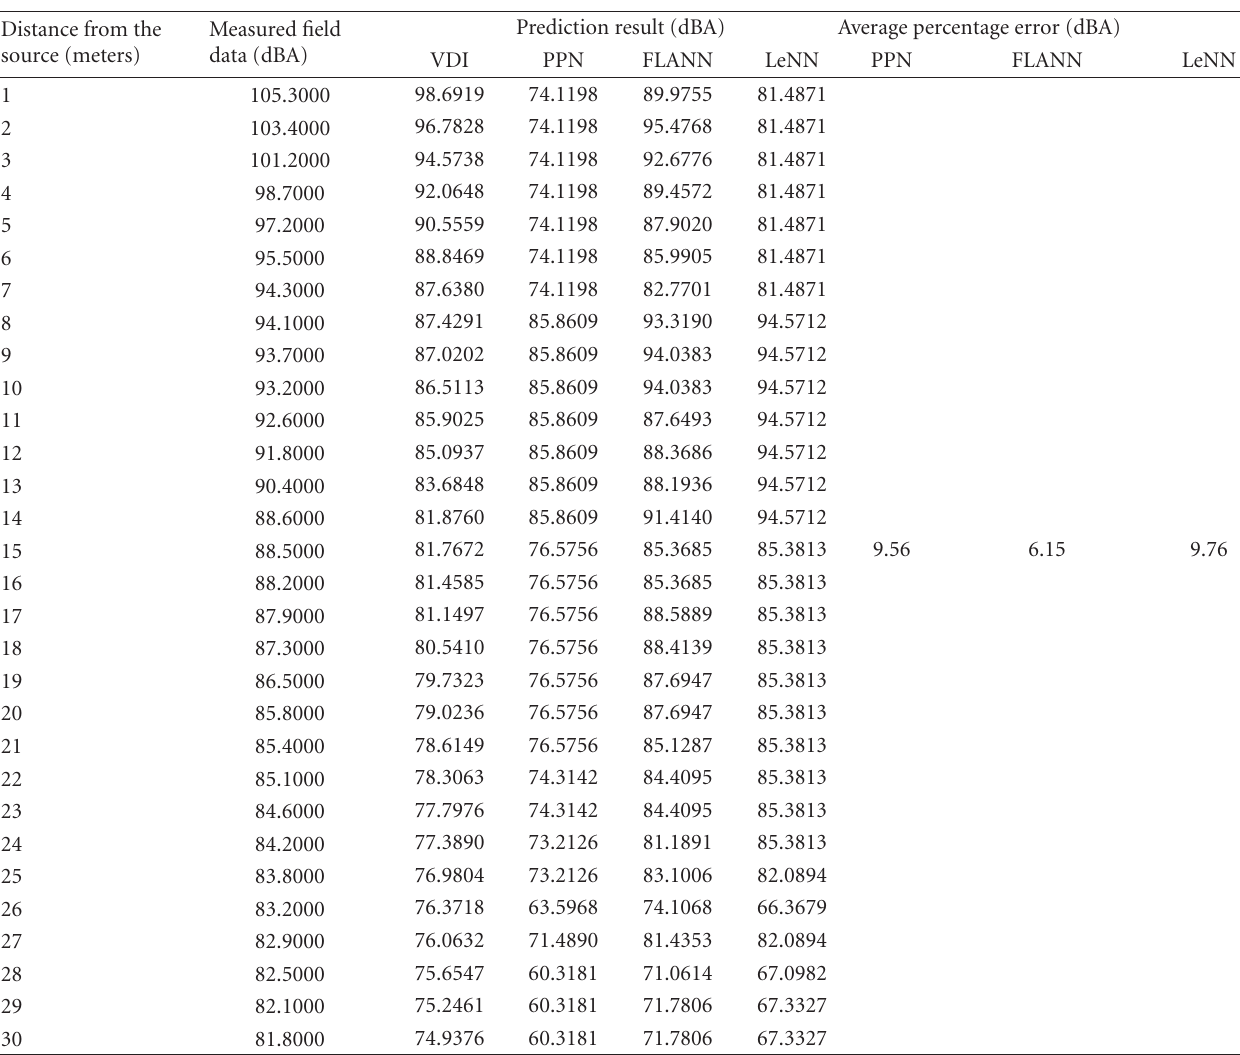
Table 3: Simulation study of grader